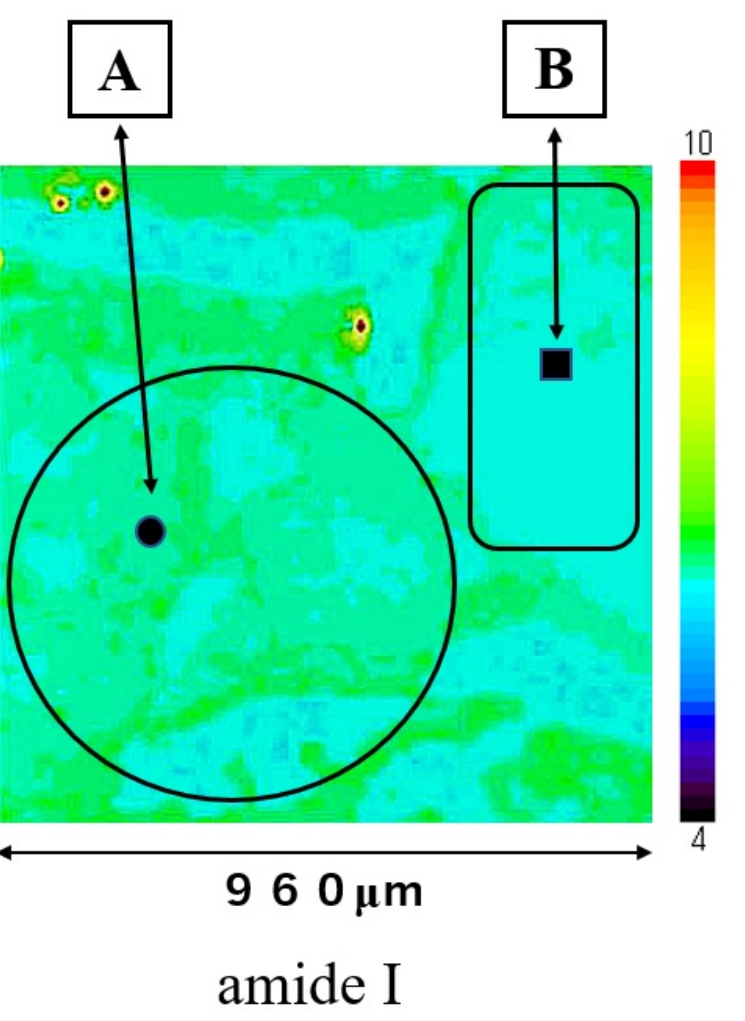
Figure 3. Mapping image of amide I is shown in the square area (960 × 960 μ m) on Figure 1. Region ( A ) is SCC and region ( B ) is normal epithelial tissue. Spectra at point ● in SCC area and at point ■ in normal area were shown in Figure 2.